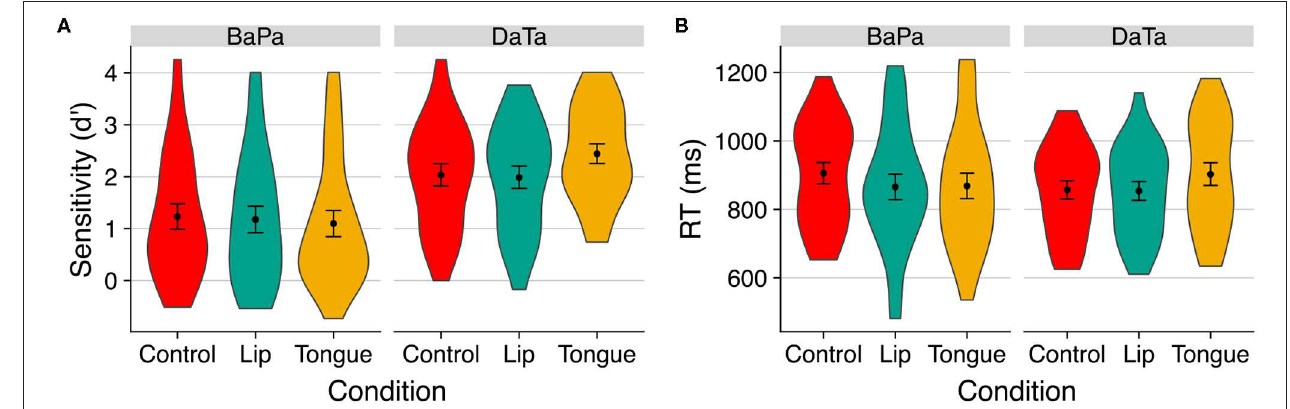
FIGURE 4 | The effect of stimulation on (A) sensitivity (d’) and (B) response time to identity trials in Experiment 2. Error bars are standard error of the